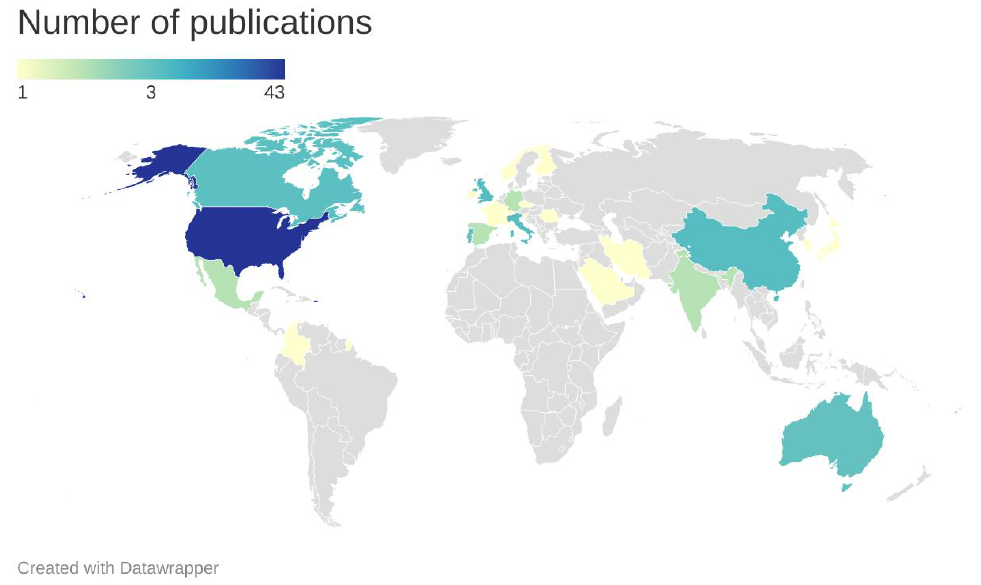
Figure 5. Distribution of the publications on low-cost corrosion monitoring by country.